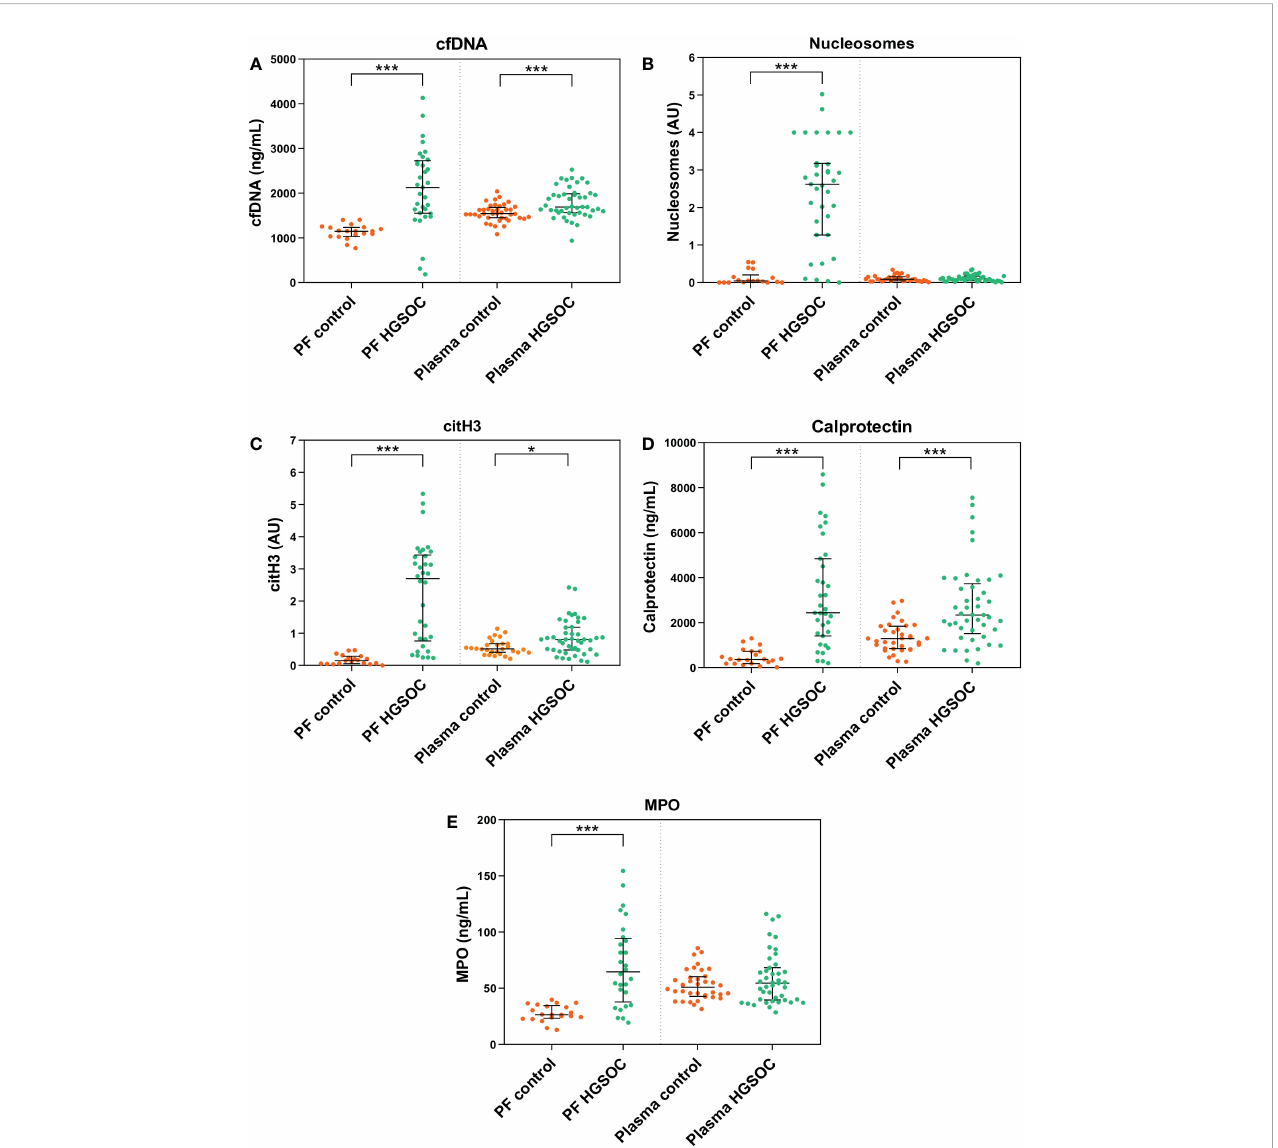
FIGURE 1 NETosis biomarkers in peritoneal fl uid (PF) and plasma samples of patients with high-grade serous ovarian cancer (HGSOC) (n=35 and n=45, respectively) and control women (n=21 and n=40, respectively). (A) cell-free DNA (cfDNA). (B) Nucleosomes. (C) citrullinated histone 3 (citH3). (D) Calprotectin. (E) Myeloperoxidase (MPO). Median values and interquartile ranges for NETosis biomarkers in both groups are listed in Supplementary Table S1. AU, arbitrary units. *** p < 0.001; * p < 0.05; Mann-Whitney U